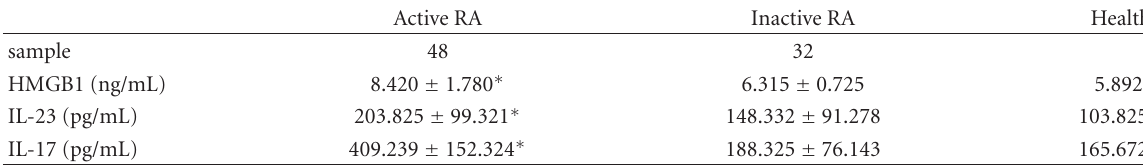
Table 2: The plasma concentration of HMGB1, IL-23, and IL-17 in RA patients.